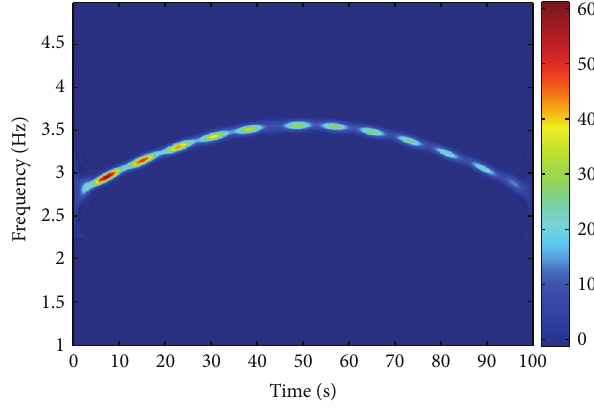
Figure 12: Modified CT spectrogram of case 2.